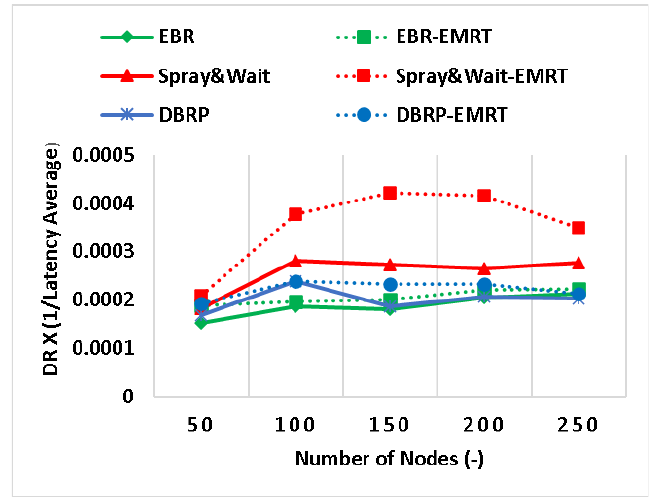
Figure 5. The DL composite metric (DR × (1/latency average)).